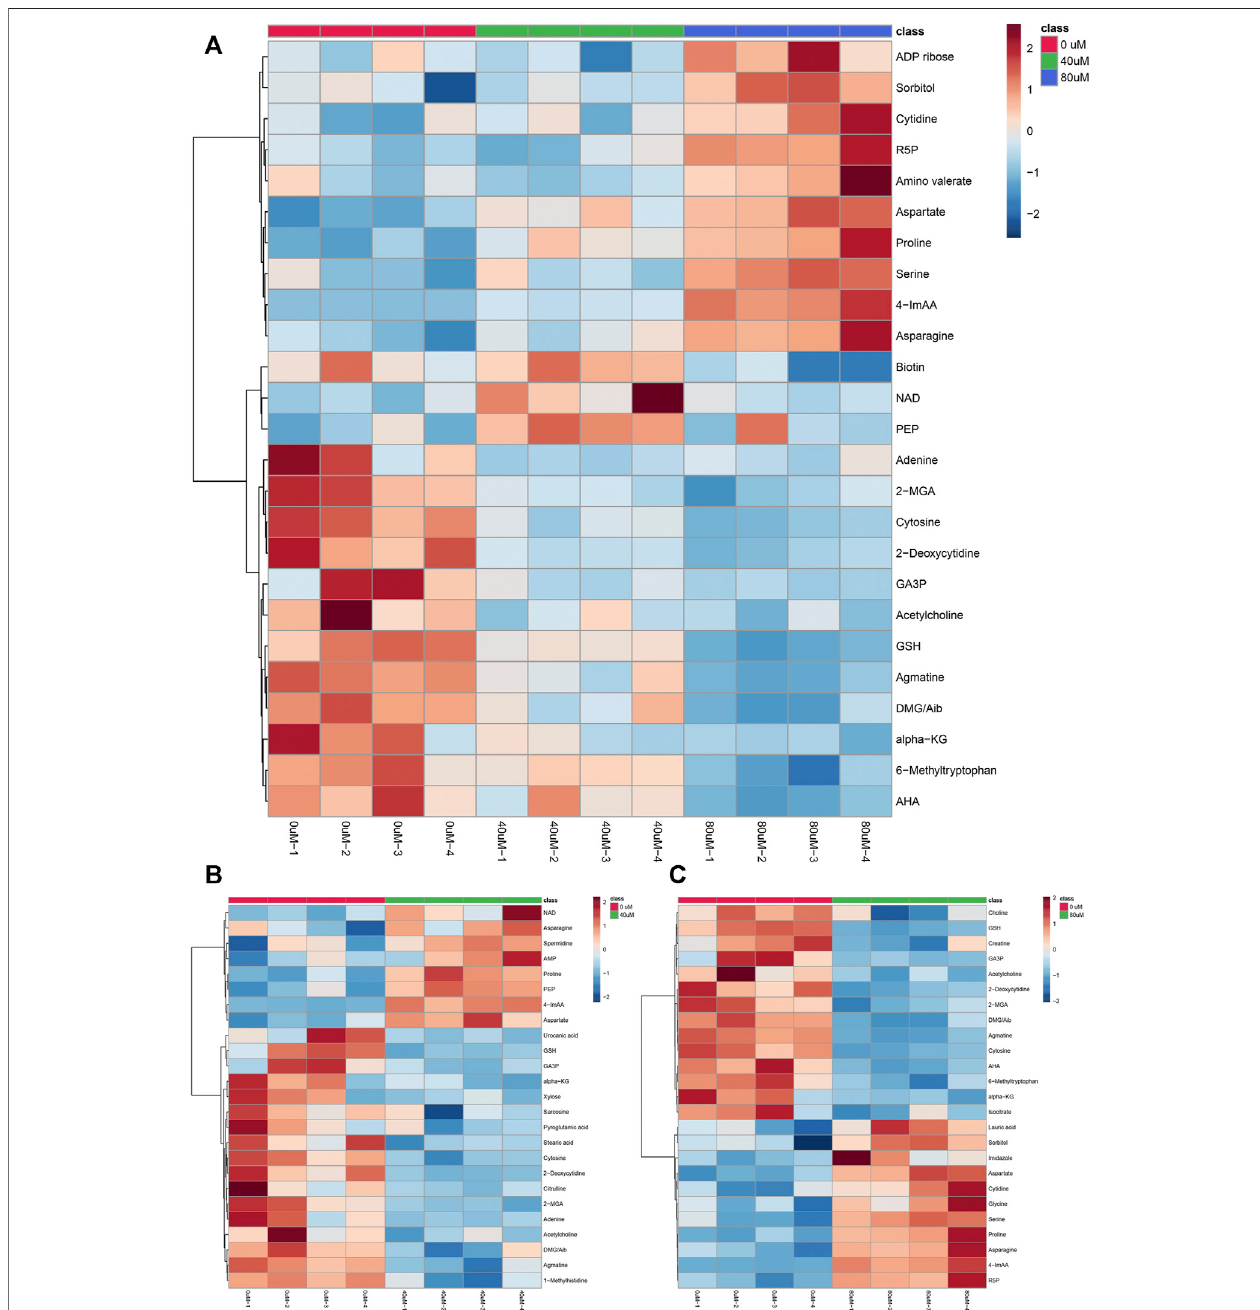
FIGURE 5 | Hierarchical clustering heat map of the top 25 differential metabolites selected based on t-tests/ANOVA, with the degree of change marked with red (up-regulation) and blue (down-regulation). The distance measure was set to “ Euclidean ” and the clustering algorithm was set to “ Ward ” . (A) : control group, 40 μ M EGCG-treated group and 80 μ M EGCG-treated group; (B) : control group and 40 μ M EGCG-treated group; (C) : control group and 80 μ M EGCG-treated group. Abbreviations: R5P, Ribose-5-phosphate; 4-ImAA, 4-Imidazoleacetic acid; NAD, nicotinamide adenine dinucleotide; PEP, phosphoenolpyruvate; 2-MGA, 2- Methylglutaric Acid; GA3P, glyceraldehyde 3-phosphate; GSH, glutathione; DMG, Dimethylglycine; Aib, 2/3-Aminoisobutyric acid; alpha-KG, alpha-Ketoglutaric acid; AHA, Acetohydroxamic acid.